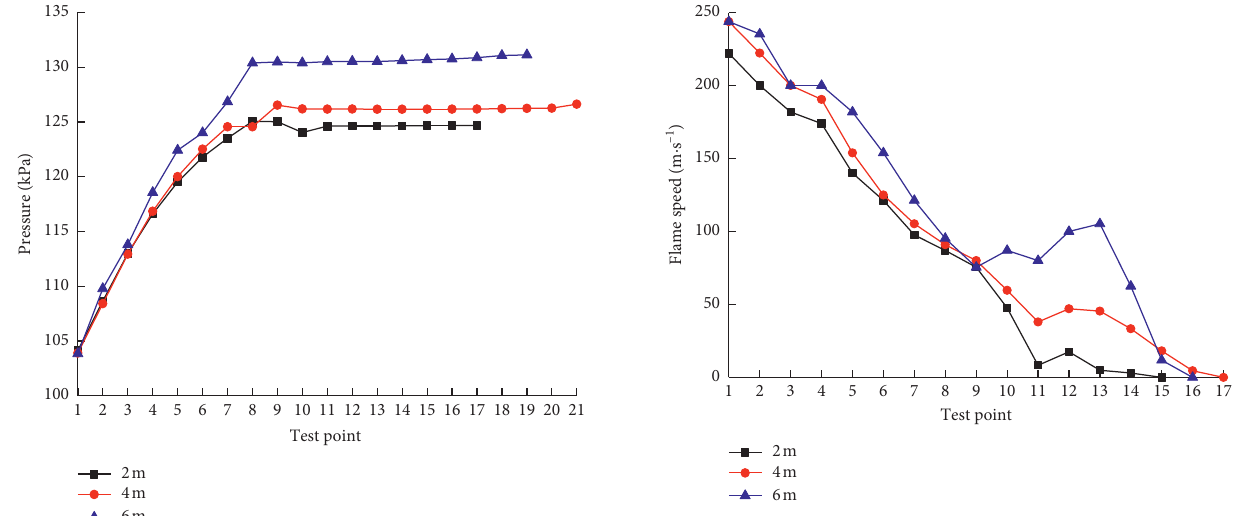
Figure 12: Curves of flame propagation velocity under different inspection well